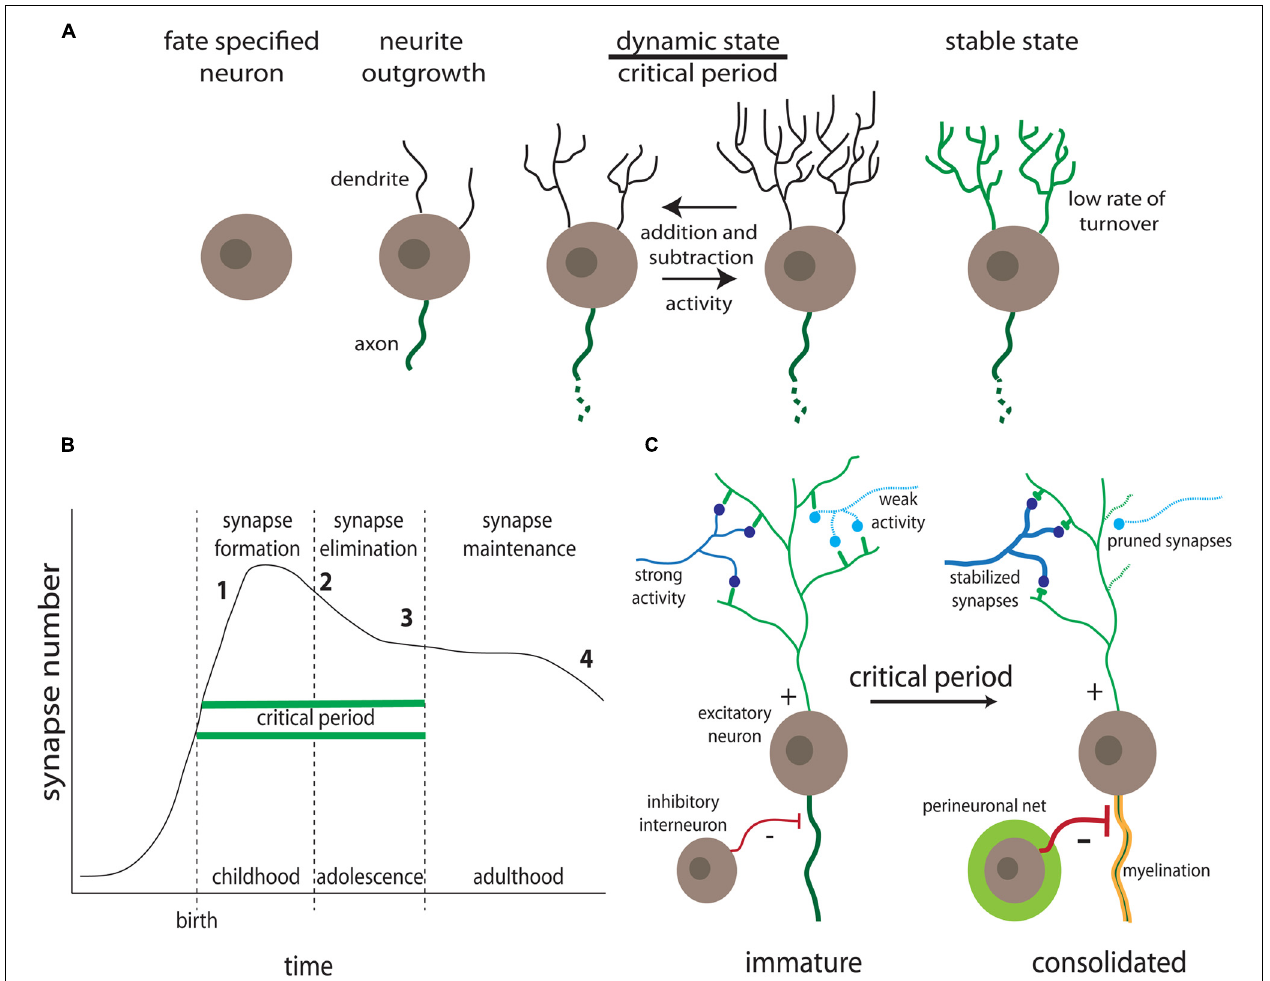
FIGURE 1 |Activity-dependent synaptic remodeling during critical periods. (A) Progression of dendrite development. Highly dynamic dendrites occur in the A-D critical period prior to consolidation of relatively stable mature connections (Kreutz and Sala, 2012). (B) Synapse number changes as a function of age. Defects in synaptogenesis (formation, pruning, and stabilization) correlate with onset of specific neurological disorder classes,